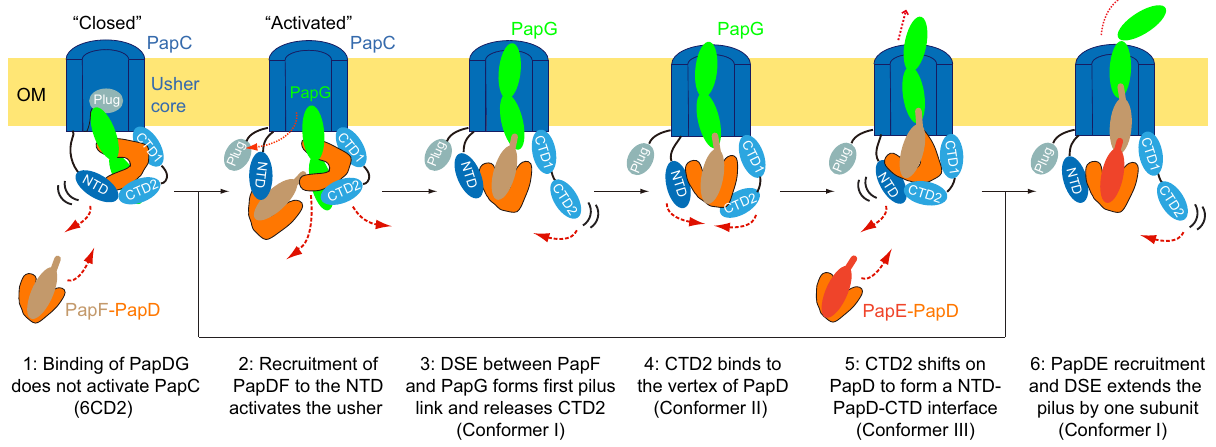
Fig. 4 Sequential model for P pilus biogenesis at the PapC usher. The illustration highlights the proposed assembly pathway, starting with the PapCDG crystal structure (6CD2) and moving through the three distinct Δ E and Δ EF conformations. See text for details. OM,